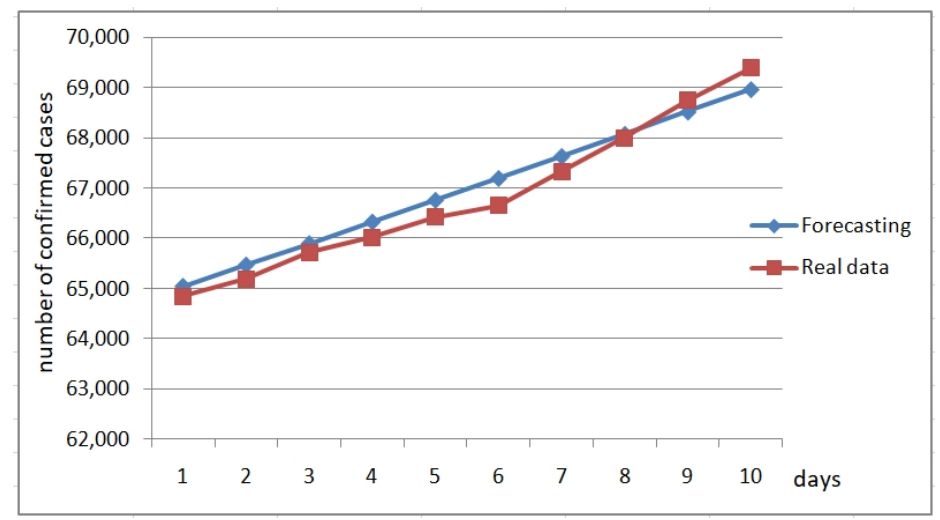
Figure 16. Forecasting the confirmed cases of Belgium from 22 July to 1 August 2020.